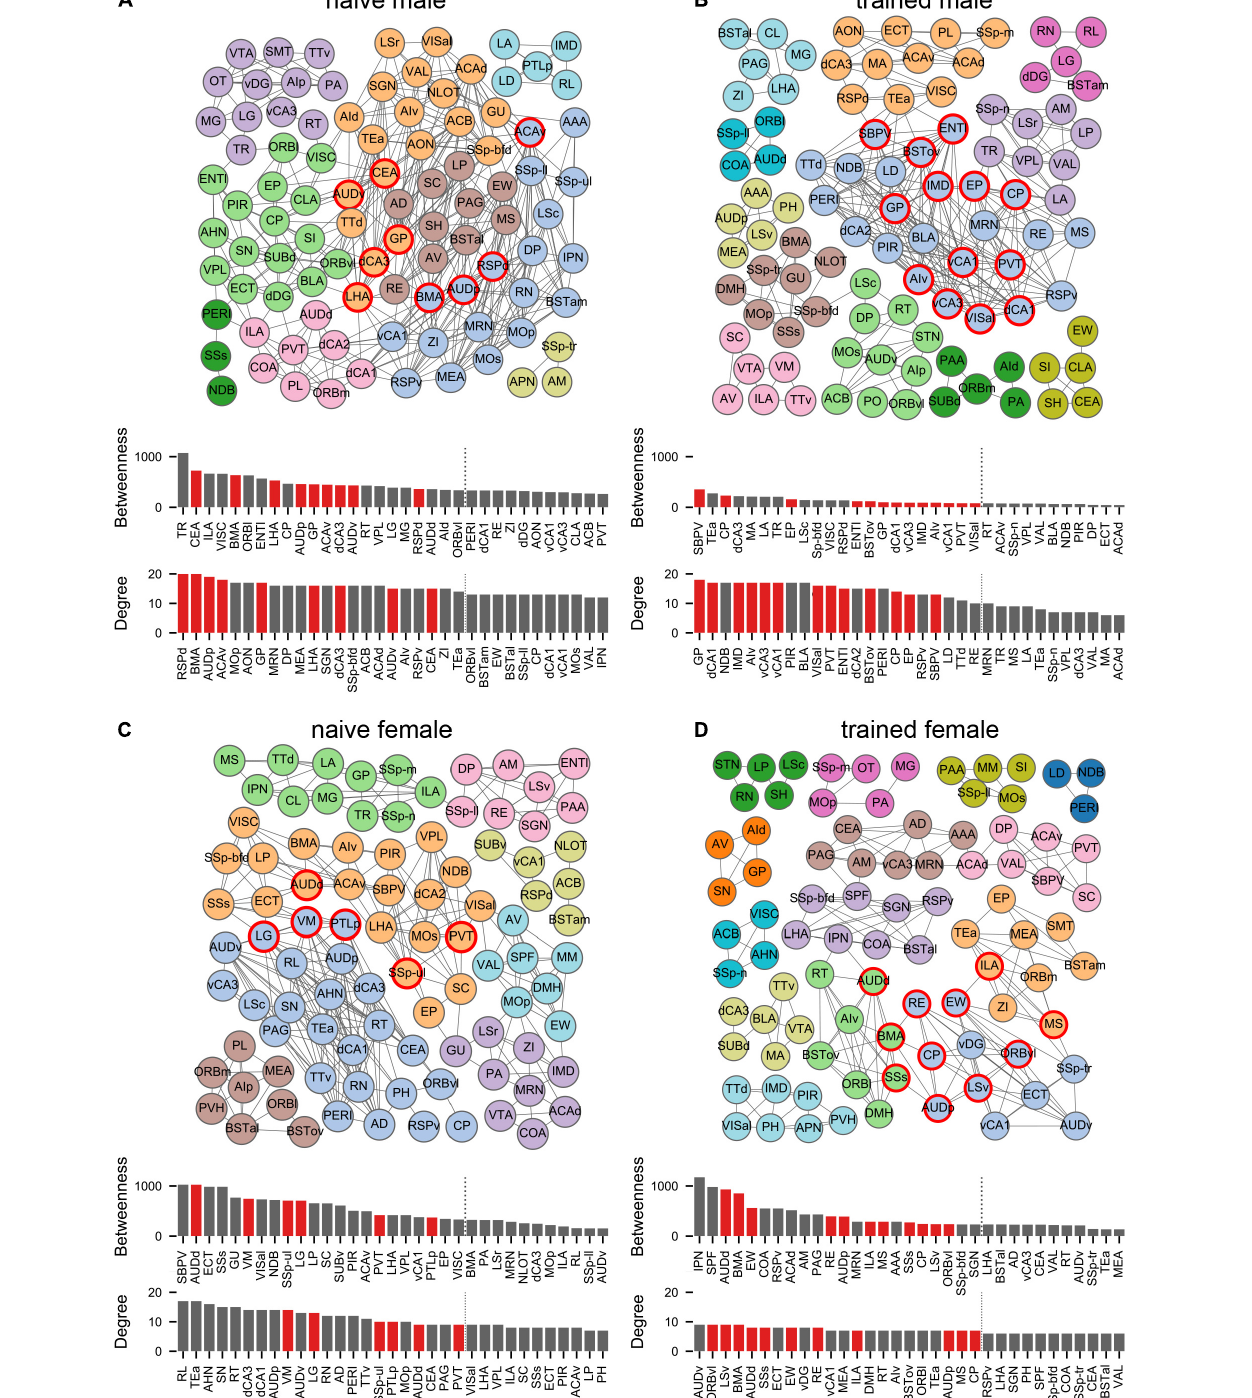
Frontiers in Systems Neuroscience |